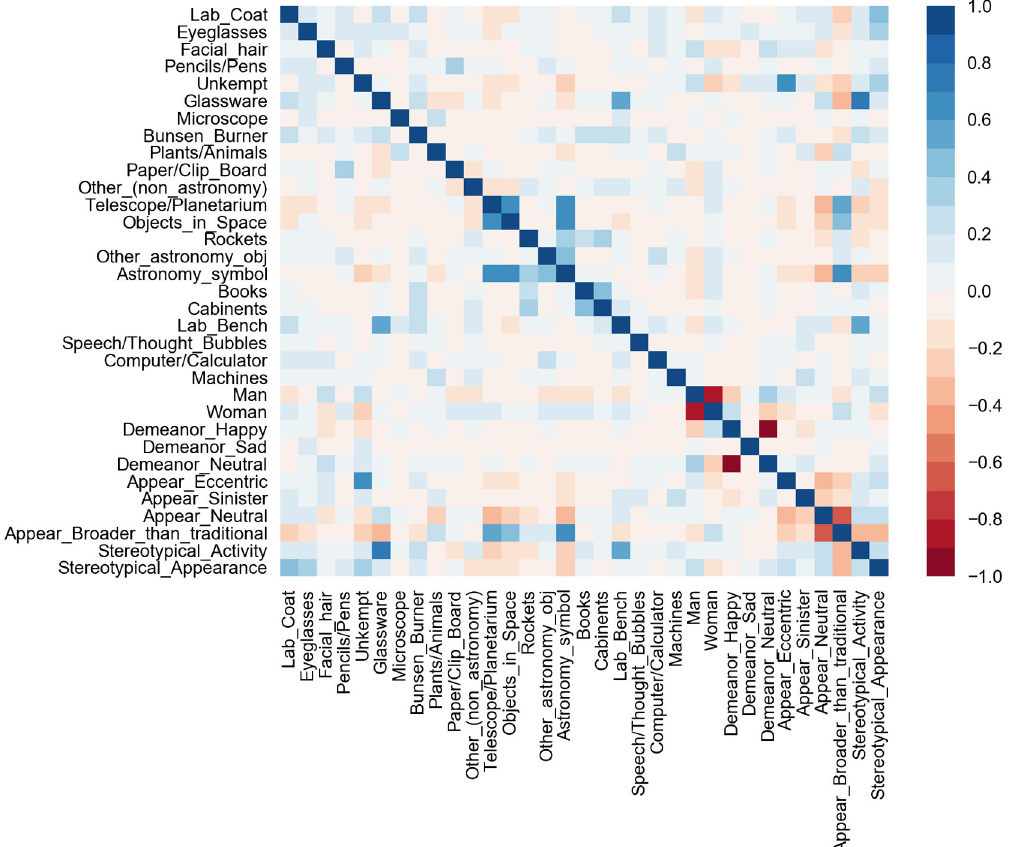
FIG. 2. Matrix showing the correlation index for each pair of DAST symbols. All indices fall between -1 and 1, where -1 indicates complete anticorrelation and 1 complete correlation.